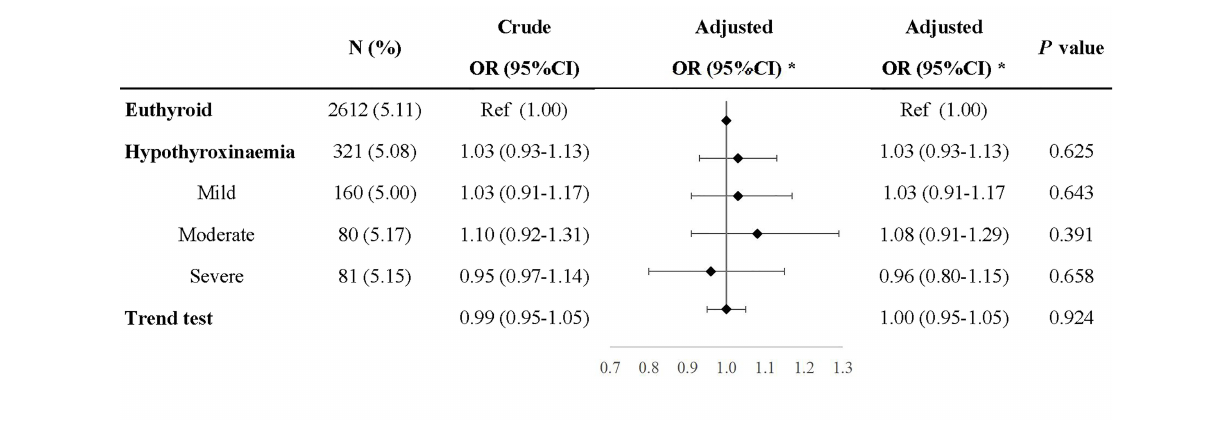
FIGURE 5 | Association of hypothyroxinemia and risk of gestational hypertension. *Adjusted for parity, age, prepregnancy BMI, fetus sex, residence of origin, serum ferritin, thyrotropin level, and TPOAb